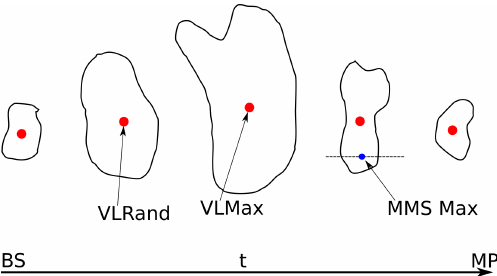
Figure 4. Illustration of the differences in detecting jets from Vlasi- ator and from MMS data (see text for details). The Vlasiator statis- tical data are given at two different times: the time of the maximum size of the jet (“VLMax”) and at a random time (“VLRand”). In both cases the data are retrieved from the position of the largest value, except for temperatures. Temperatures are averaged over all positions within the jet. The time or place of the MMS jet cross- ing is not known relative to the jet lifetime; therefore MMS data are given when MMS is observing the jet, i.e. at time “MMS Max”, illustrated in